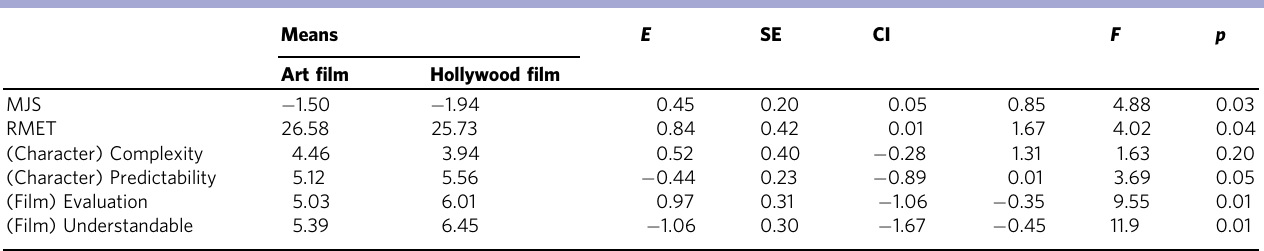
Table 1 Effects of type of fi lm (Art vs. Hollywood fi